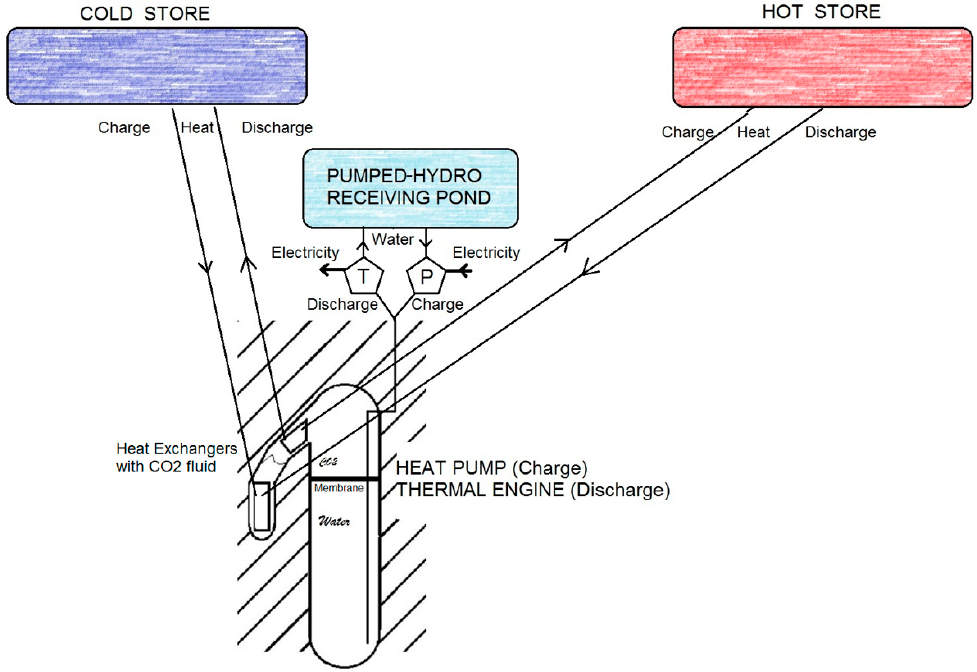
Figure 6. Principles for a PTES (Pumped Thermal Electricity Storage) using a UPHES (Underground Pumped-Hydro Energy Storage) as the locus of energy conversion.